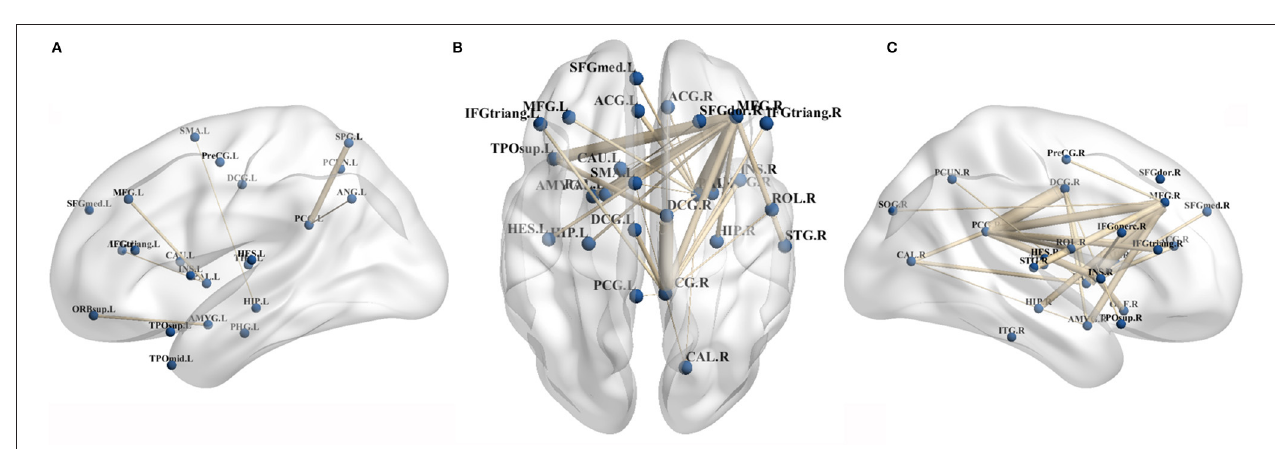
FIGURE 3 | Primary CCD related decreased brain connectivity in morphological connectivity analyses. (A,C) Showed decreased connectivity within left and right hemisphere, respectively. (B) Showed decreased inter-hemispheral connectivity in patients with CCD. ACG, anterior cingulate gyrus; AMY, amygdala; ANG,